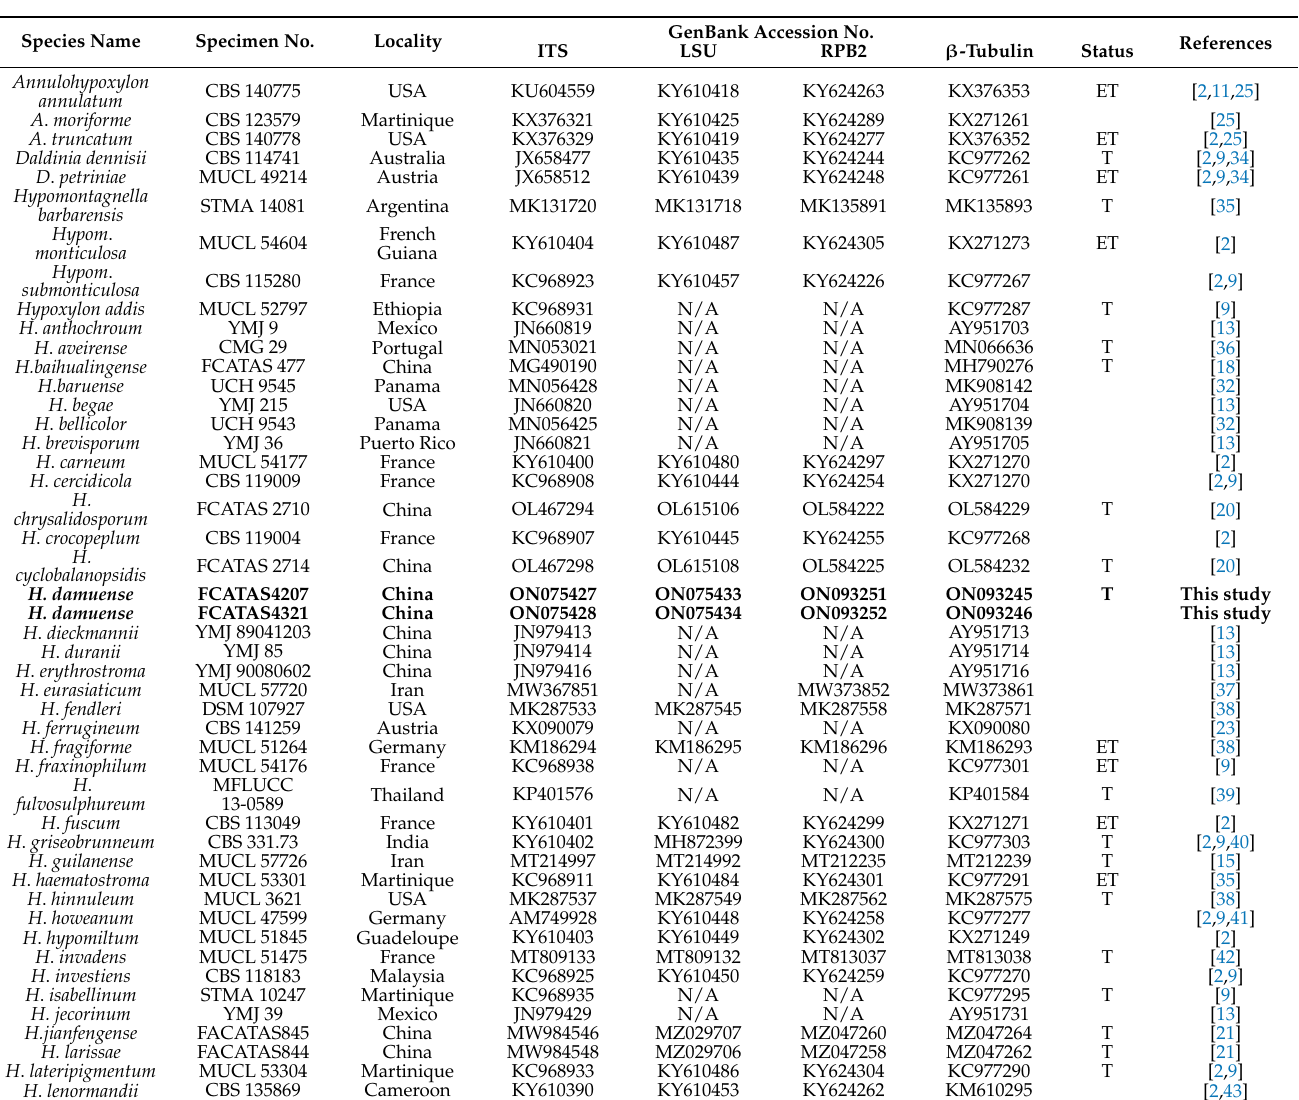
Table 1. GenBank accession numbers of sequences used in the multi-gene phylogenetic analyses. T and ET represent holotype and epitype specimens, respectively. Species in bold were derived from this study. N/A: not